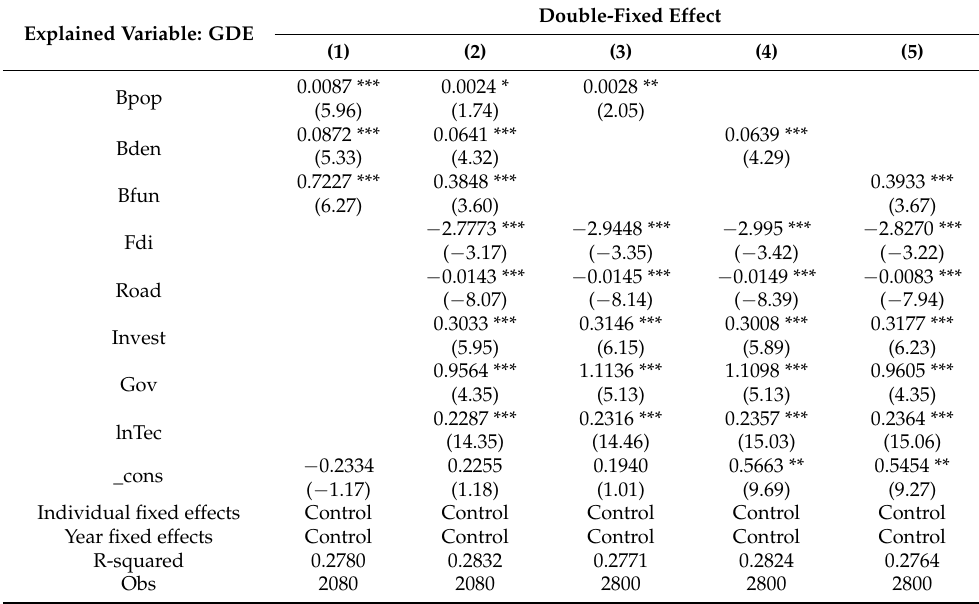
Table 4. Analysis of baseline regression